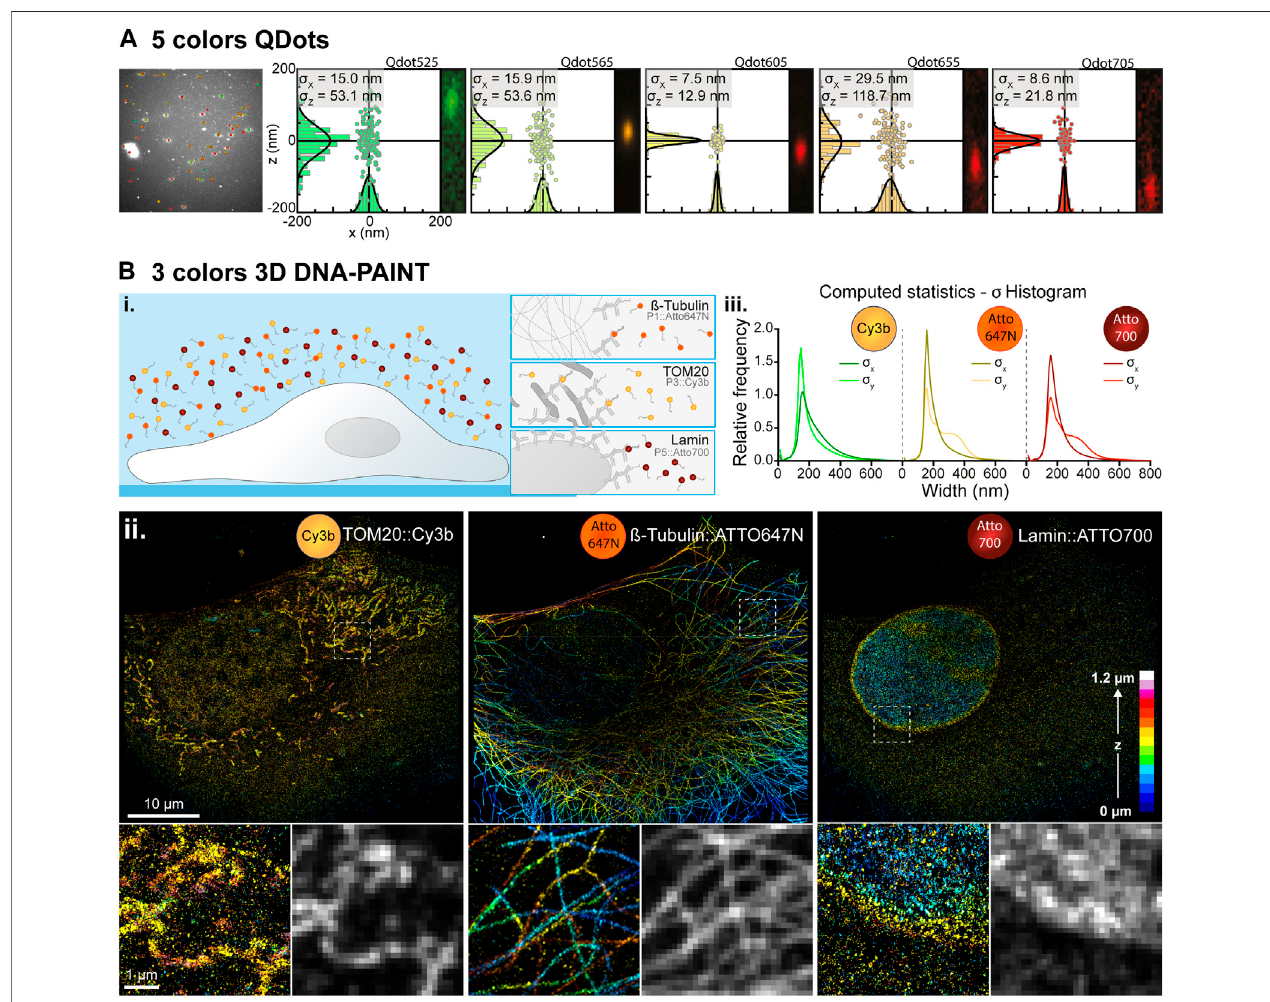
FIGURE2| Simultaneousmulti-colorsinglemoleculedetection. (A) Simultaneousdetectionof fi vespectrallydifferentQdots.Left:Imageofa fi eldofviewcontaining fi ve spectrally different populations of Qdots with their overlaid localization and emission wavelength determined by spectrally displaced localization. Right: Spectral localizationsofQdotscomputedfrom1,000consecutiveframesforeachpopulationofQDotswiththeirlocalizationhistogramalongthex-andz-axisandtheassociated Gaussian fi tting(blackcurves)forpointingaccuracyestimation.TheinsetsrepresenttheimagesofthoseQdotsinthespectral(upper)channelinsidethepairsearch zone. (B) Simultaneous three colors 3D DNA-PAINT imaging. (i.) Experiment principle: Three biological structures of interest (microtubule, TOM20 and LaminB1) are labelledwithinaCOS-7cell withorthogonal DNAdocking strands each associatedwithanimagerstrandconjugatedtoadifferent fl uorescent dye (Atto647N, Cy3b and Atto700 respectively). (ii.) Depth color-coded super-resolved 3D reconstructions of the three structuresofinterestacquired simultaneously and fi ltered in wavelength to extract each of the three dyes populations. Intensity images have been reconstructed using the ImageJ ThunderSTORM plugin to create a blur effect according to the singlemoleculelocalizationprecision.Thelowerpanelsrepresentzoomed-inimagesofthedottedwhiteboxesandtheircomparisonwithdiffraction-limitedimagesofthe same areas reconstructed using a fi xed Gaussian blur of 100 nm (resp. 250 nm) standard deviation in XY (resp. Z), to simulate diffraction limited spatial resolutions of 230 nm (resp. 575 nm). (iii.) Histograms of the astigmatism-based PSF widths along the x- ( σ x ) and y-axis ( σ y ) for each dyes ’ population computed by bidimensional Gaussian fi